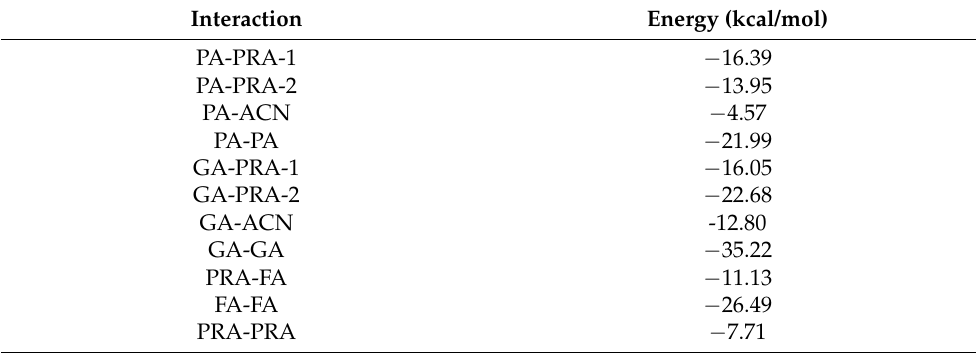
Table 3. Intermolecular interaction energy between different components in the